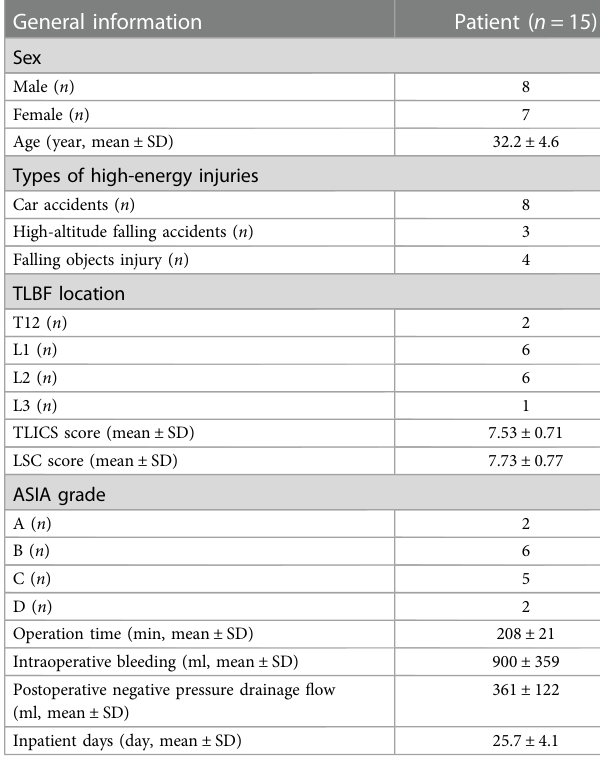
TABLE 1 Characteristics of 15 patients before, after surgery, and at 1-year after surgery. General